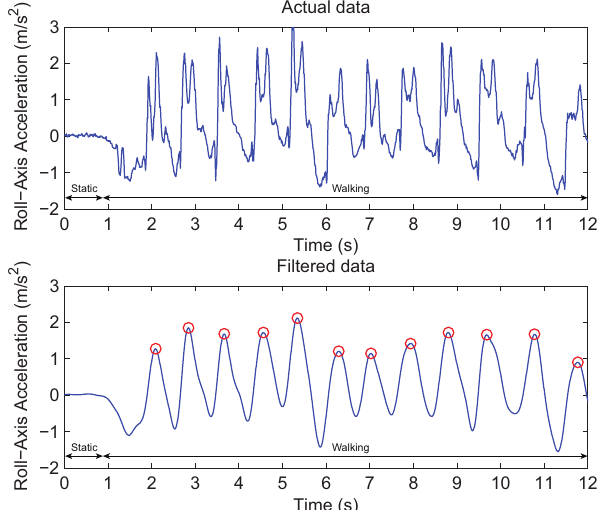
Figure 2. Example of the step detection using accelerometer readings. ( Top ) Raw acceleration values measured during the walking. ( Bottom ) Smoothed acceleration magnitudes using 10th-order Butterworth low pass filter. Peaks represented by red circles correspond to the user steps.